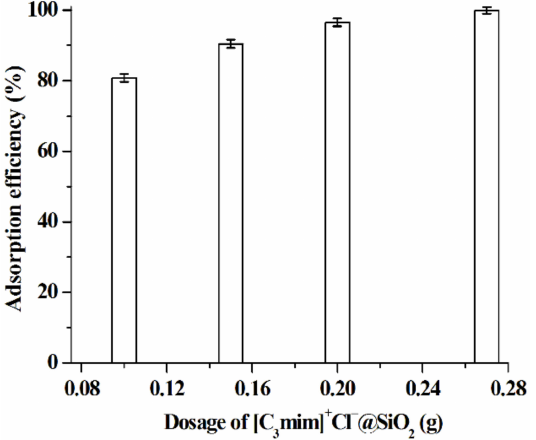
Figure 11. Effect of dosage of [C 3 mim] + Cl − @SiO 2 on the adsorption of baicalin from 10 mL of the root extract of SBG. Experimental conditions: C baicalin = 1.9 × 10 − 3 mol · L − 1 ; adsorption time, 10 min; pH 5.0; adsorption temperature, 25 ◦ C. Experiments were conducted in triplicate.